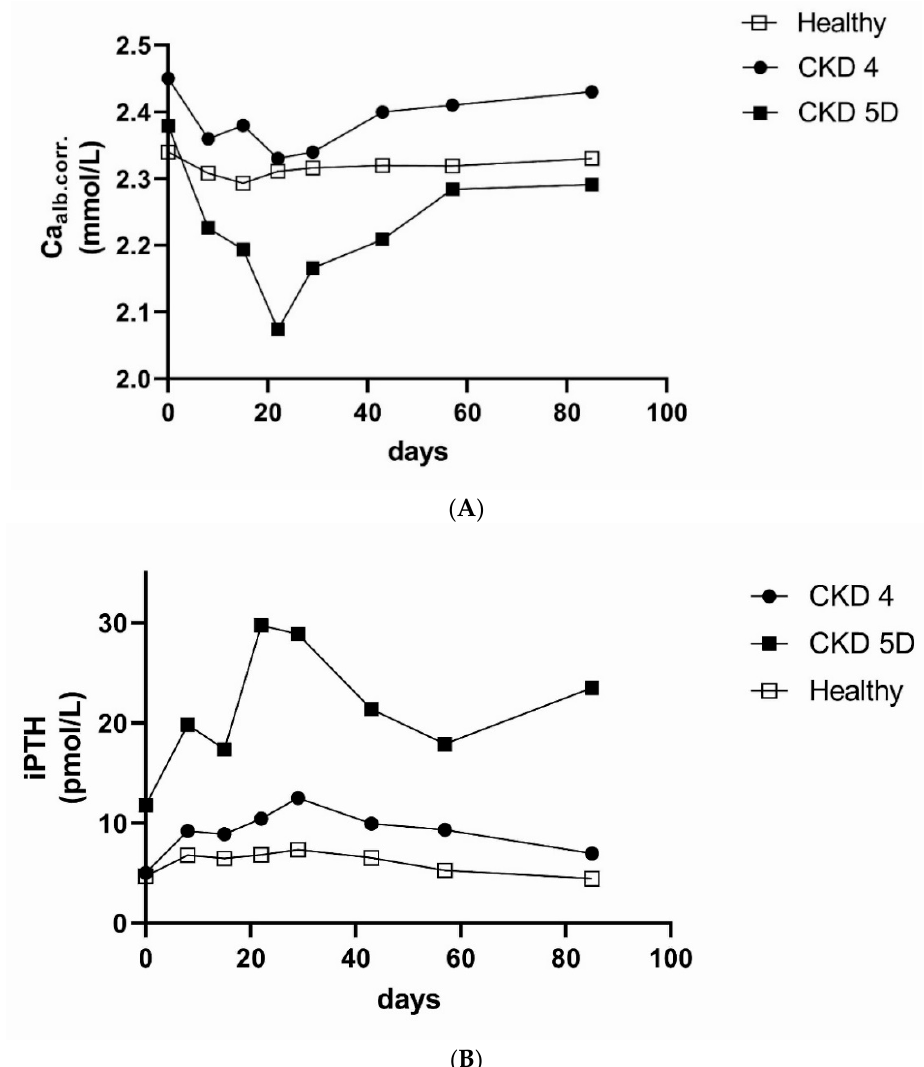
Figure 3. Mean values of ( A ) albumin-corrected calcium (Ca alb.corr.) and ( B ) intact parathyroid hormone (iPTH, log-scale) after a single injection of romosozumab 210 mg according to renal func- tion. Adapted from [87]. Healthy—healthy controls; CKD 4—chronic kidney disease stage 4; CKD 5D—chronic kidney disease stage 5D (dialysis).